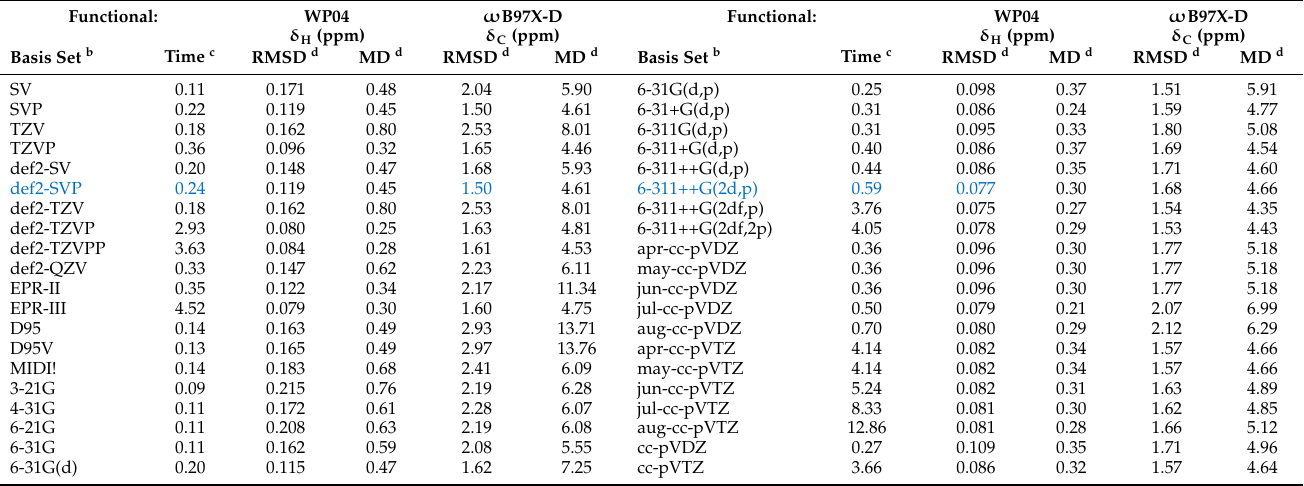
Table 3. Impact of basis set on accuracy of 1 H and 13 C NMR chemical shift predictions a